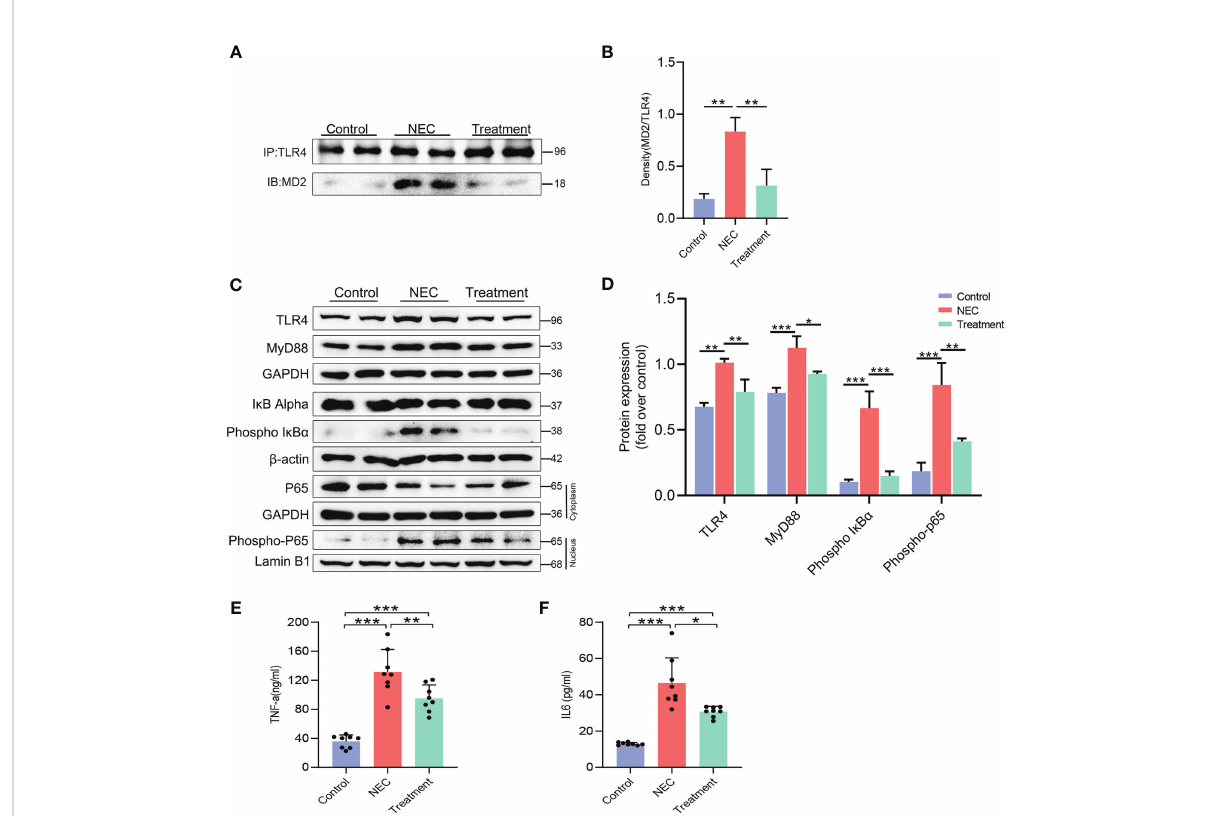
FIGURE 3 Blocking MD2 inhibits NF- k B and in fl ammatory responses in NEC rats. (A, B) Immunoprecipitation assays showed that MD2 inhibitor pretreatment signi fi cantly reduced the formation of the TLR4 – MD2 complex in rat intestinal tissue. IB indicates immunoblotting antibody, and IP indicates precipitating antibody (n=3). (C, D) Western blot analysis of TLR4 signaling-related proteins, NF- k B activation and nuclear translocation of the p65 subunit of NF- k B (n=3). (E, F) TNF- a and IL-6 levels in intestinal tissue lysates were detected by ELISA, and values were normalized to the total protein (n=8). The p value was analyzed by one-way ANOVA with multiple comparisons, followed by Tukey ’ s post hoc test. *p <0.05, **p <0.01, ***p